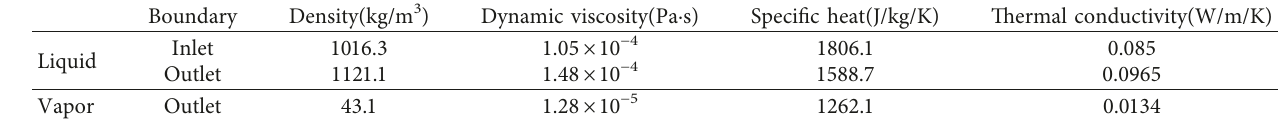
Table 1: Physical parameters.